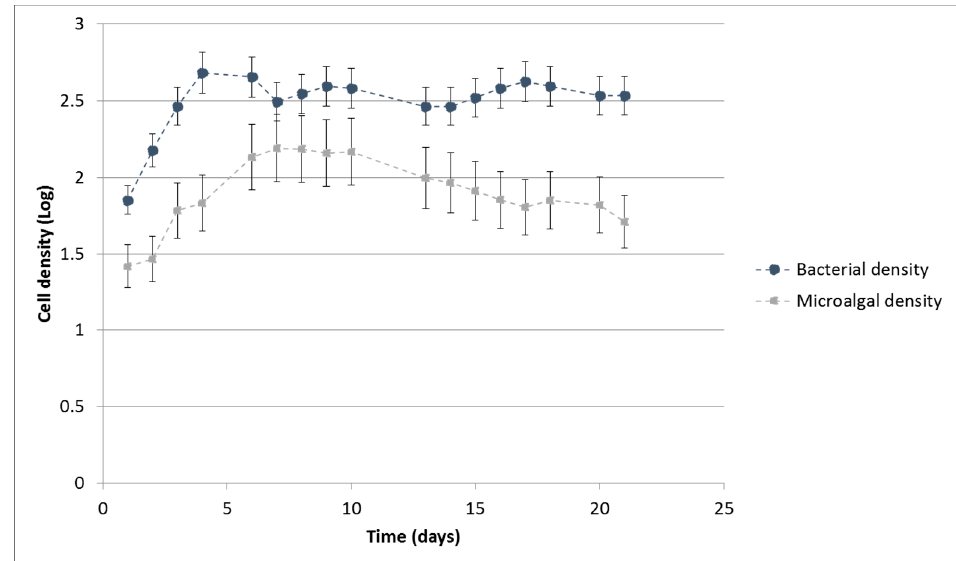
Figure 6. Planktonic cell density for the co-culture of bacteria (units: DO 600nm ) and microalgae (units: arbitrary units of fluorescence, λ excitation = 633 nm, λ emission = 638–720 nm) in photobioreactor. Data represent the mean ± standard deviation of replicates.